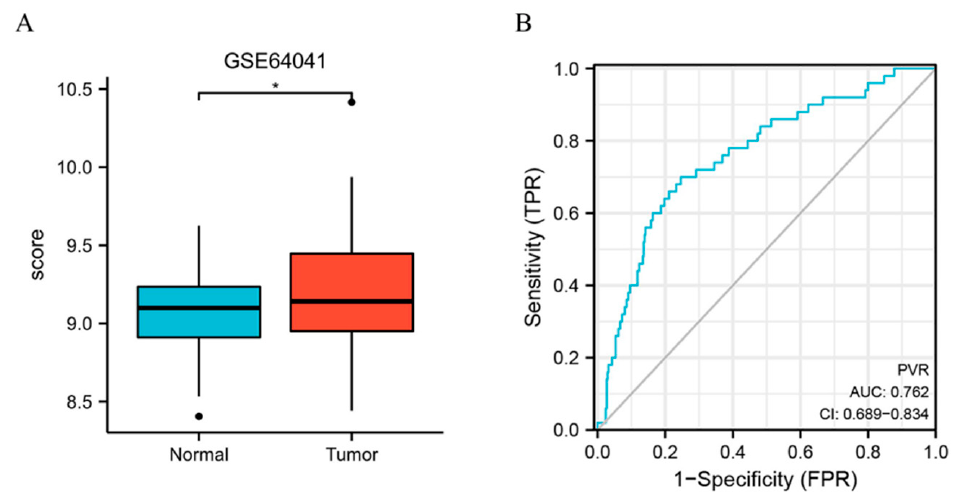
Figure 2. PVR expression in the GEO database. ( A ) PVR expression in the normal and tumor tissues in HCC from GSE64041. ( B ) ROC curve of PVR in HCC. * p < 0.05.